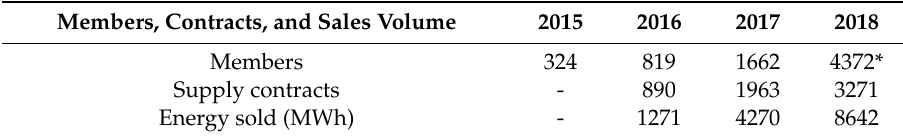
Table 3. Members, contracts, and sales volume of È nostra between 2015 and